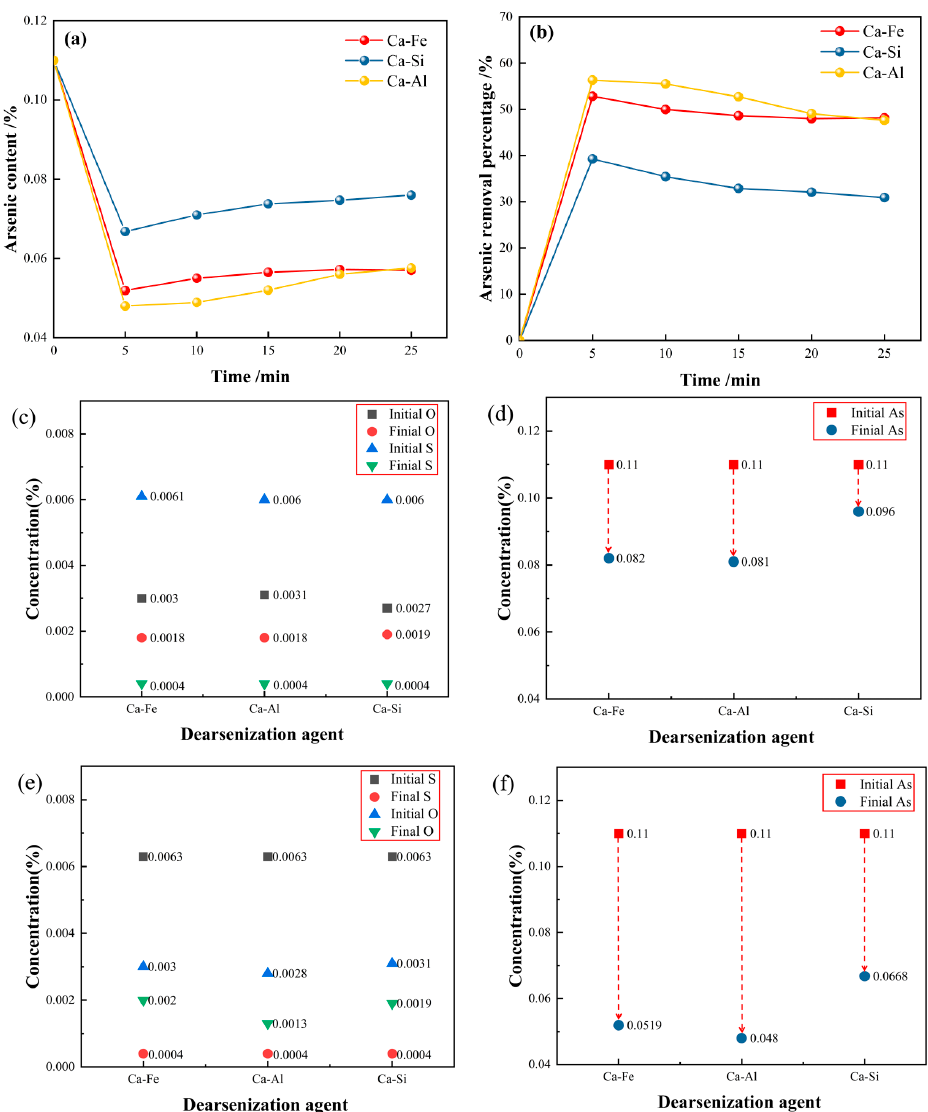
Figure 1. ( a , b ) Time varying curve of arsenic content and arsenic removal percentage; ( c – f ) change of chemical element content in steel. Table 2. Three types of calcium alloy dearsenication agent experiment changes in arsenic content change (wt.%).